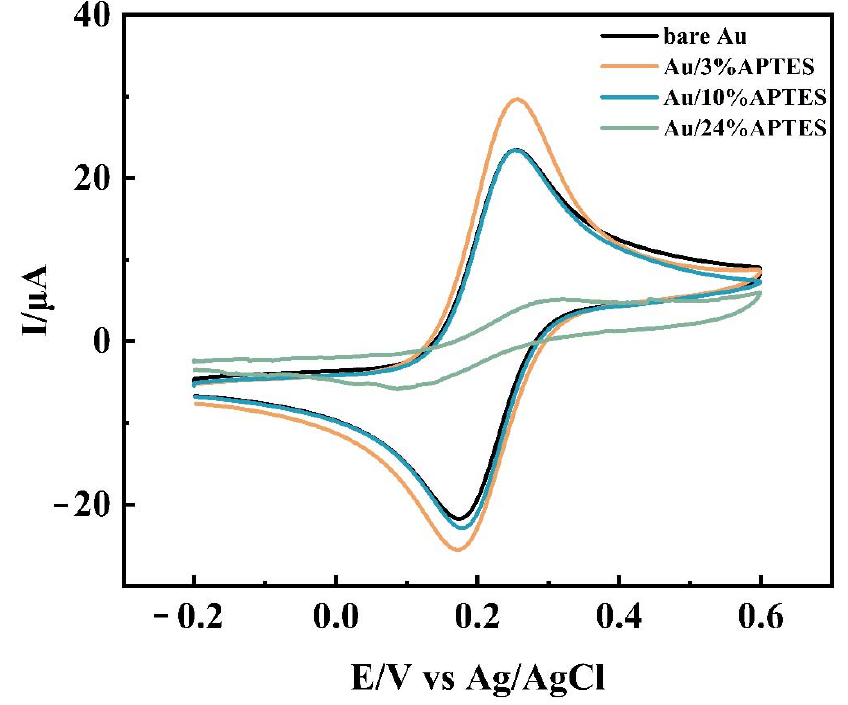
Figure 6. The CV curves of bare gold, Au/3%APTES, Au/10%APTES, and Au/24%APTES electrodes were measured in 0.1 mol/L KCl solution containing 5 mmol/L [Fe(CN) 6 ] 3 − /4 − .